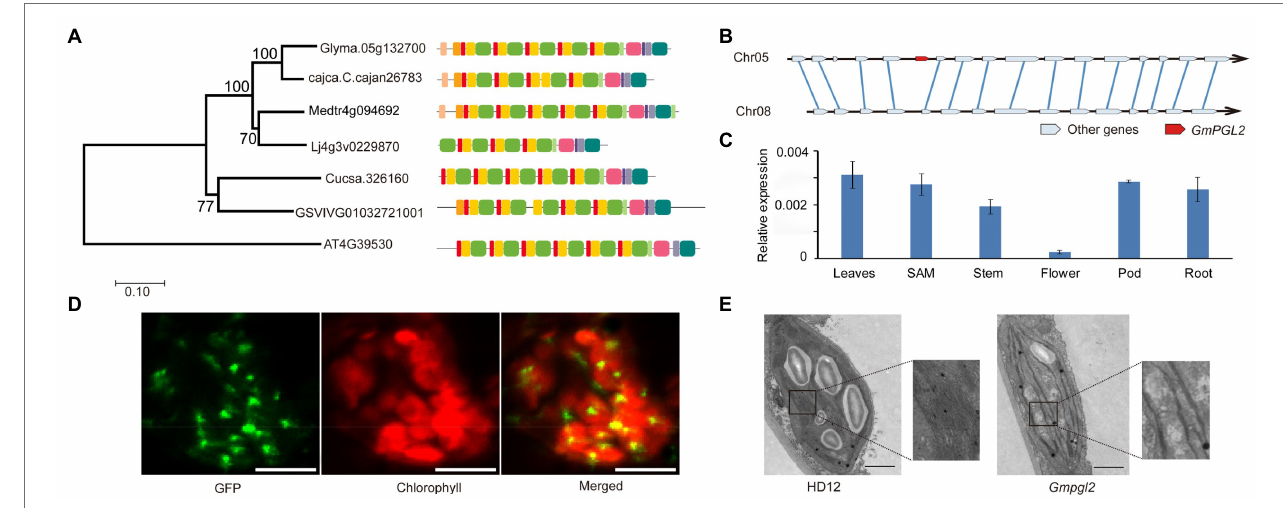
FIGURE 3 | GmPGL2 is a single copy gene. (A) Phylogenetic tree of GmPGL2 and homologous GmPGL2 proteins from Arabidopsis thaliana , Medicago truncatula , Lotus corniculatus , Cajanus cajan , Cucumis sativus , and Vitis vinifera , constructed using MEGA 5 with the neighbor-joining method. (B) Synteny plot of the homologous GmPGL2 regions. Solid blue lines show the pairs of homologous genes of the two homologous chromosomes. (C) Expression of GmPGL2 in different tissues. (D) Subcellular localization of GmPGL2. GFP signals of the 3301H- GmPGL2 1-198 - GFP fusion protein were localized to the chloroplast of epidermal cells of N. benthamiana leaves. Green fluorescence signals, chlorophyll auto-fluorescence signals, and a merged image are shown. Bar = 10 μ m. (E) Transmission electron micrographs of the chloroplasts of 18-day-old HD12 and Gmpgl2 seedlings. Bar = 2 μ